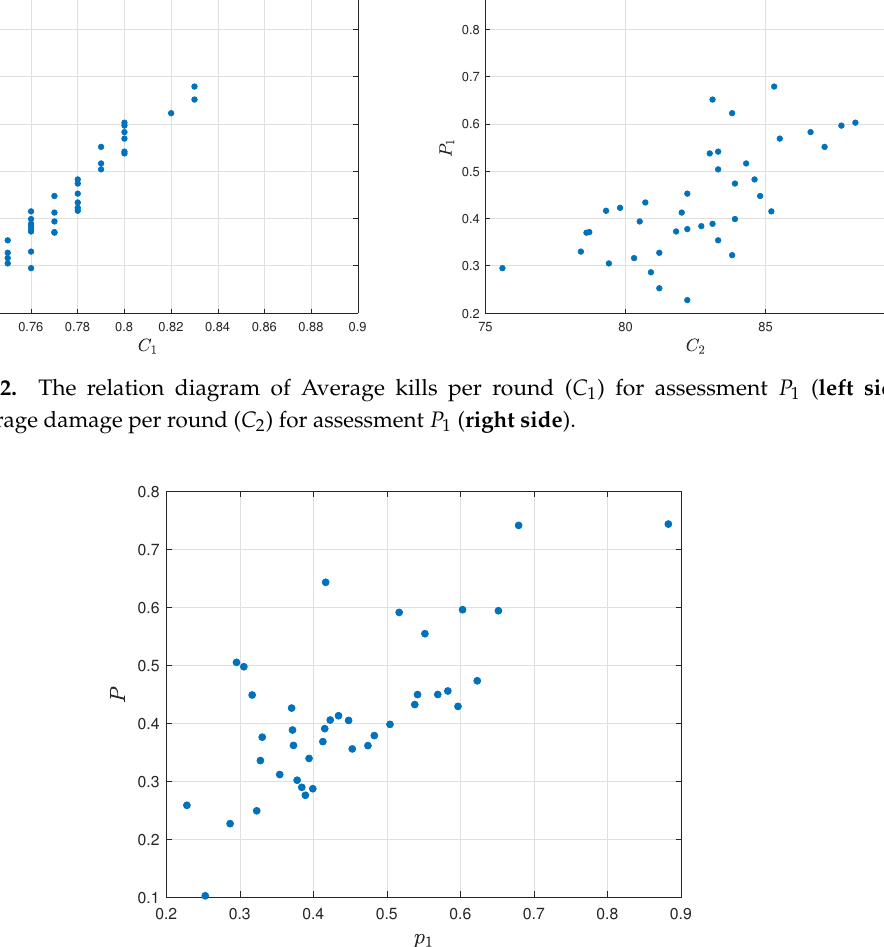
Figure 23. The relation diagram of the Effectiveness per round assessment ( P 1 ) for final assessment P .